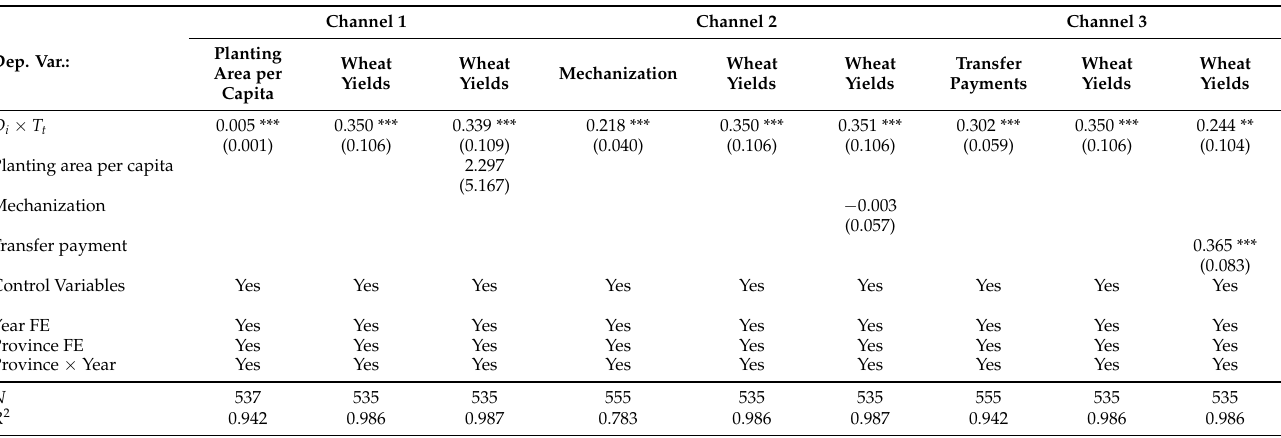
Table A2. The channels of